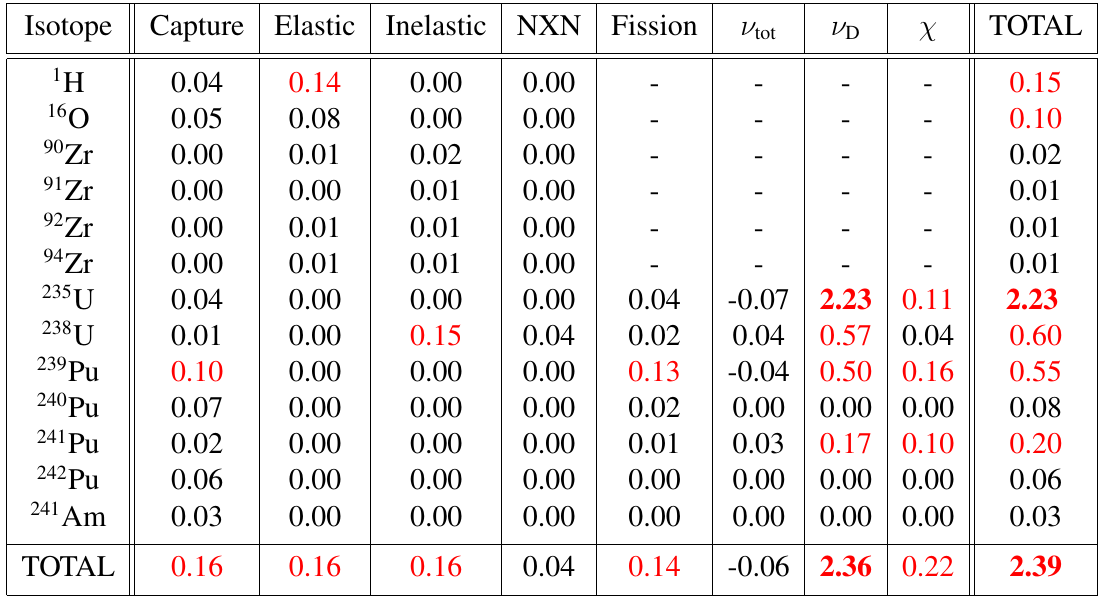
Table 2: Uncertainty propagation (in %) of beta effective for the Epicure UM17x17 experiment. Negative values stand for imaginary values, negative contribution to the overall